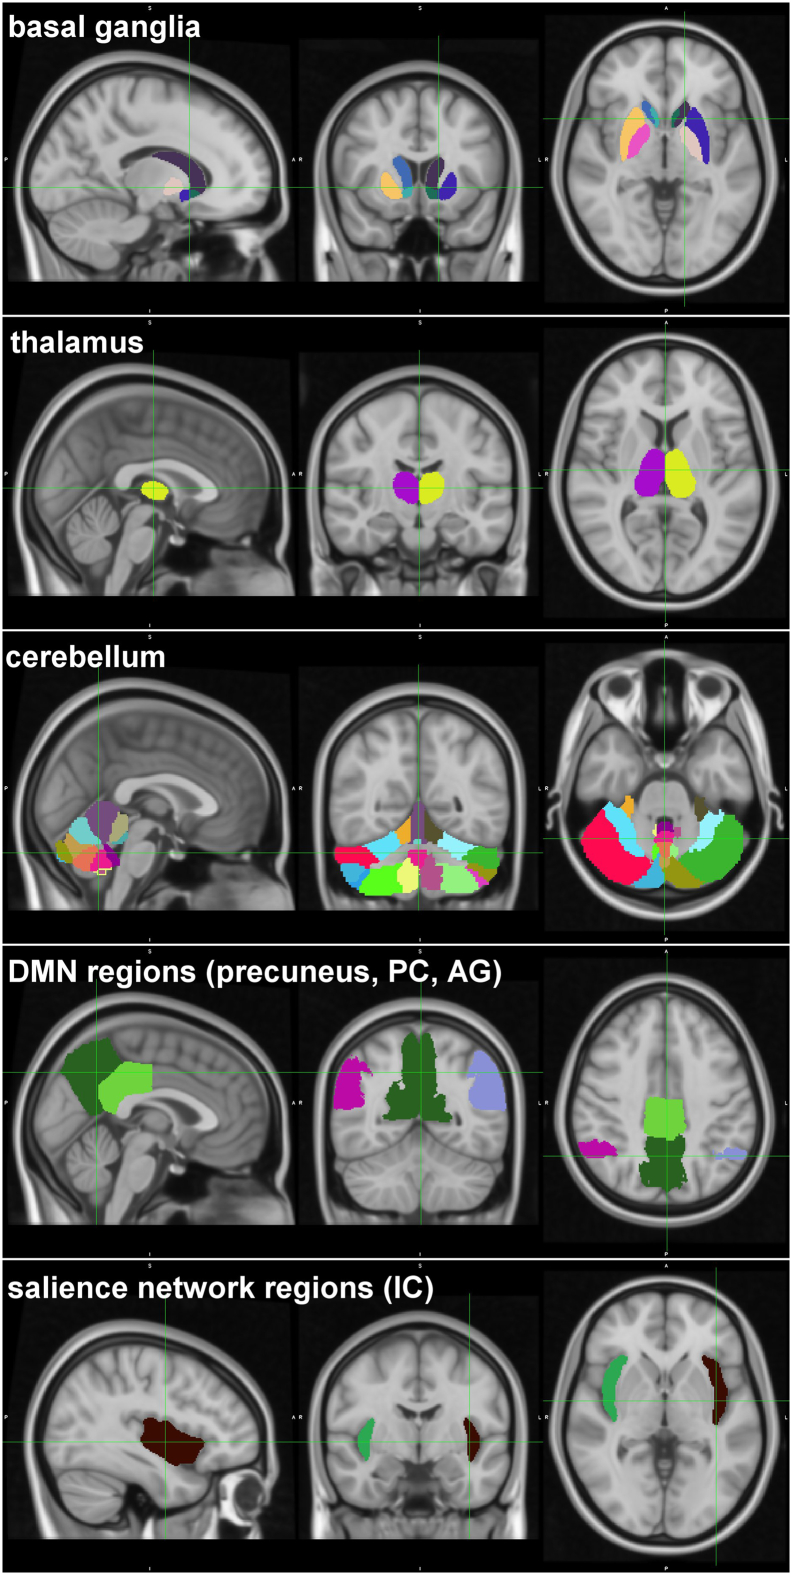
Parcellations of the different regions of interest we investigated – the basal ganglia (8 ROIs), thalamus (2 ROIs), cerebellum (26 ROIs), default mode network (4 regions), salience network (2 regions). Since the DMN and salience network were not specifically investigated, only those regions which showed alterations in TS in this study have been depicted here. The colour scheme is random, the different colours represent the different regions.